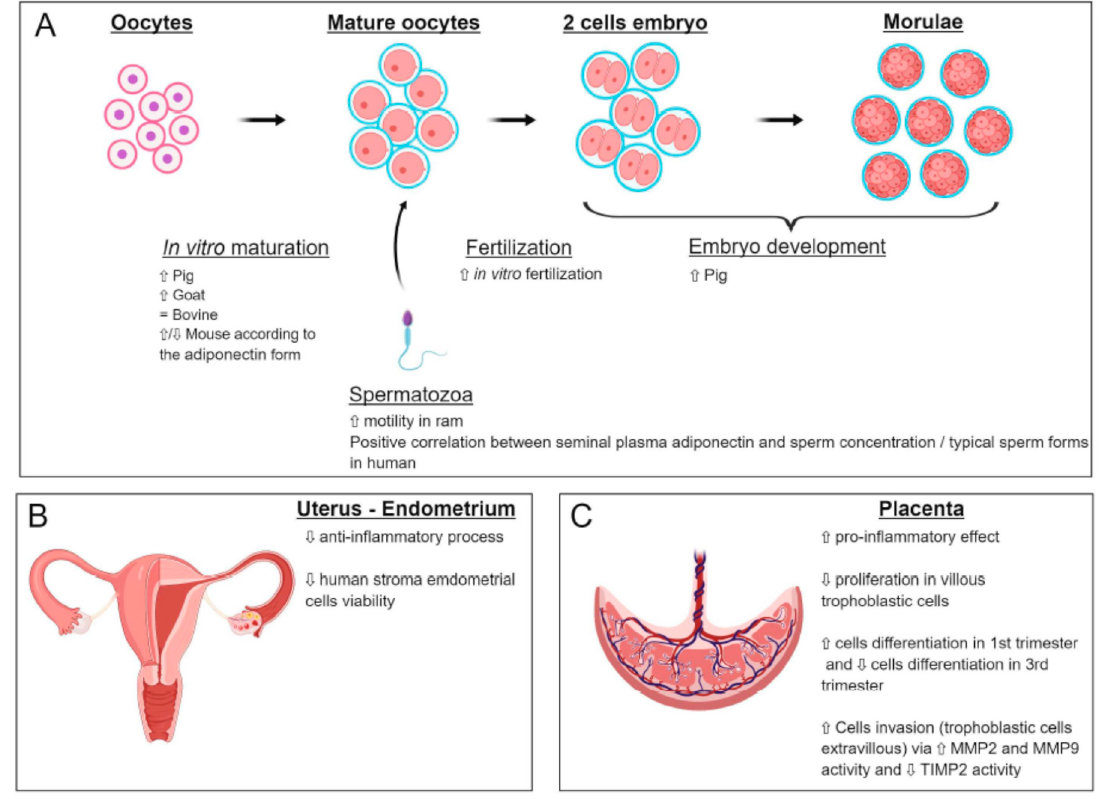
Figure 3. Adiponectin receptors and some examples of biological effects of adiponectin in reproductive tissues or cells. Adiponectin interacts with adiponectin receptors (mainly AdipoR1 and AdipoR2) to activate or inhibit a number of signalling pathways. T Cadherin receptor (T Cadherin R) binds the hexameric and high molecular weight isoforms of adiponectin but it has no intracellular domain. AdipoR1- and R2-dependent signalling is mediated through APPL 1 and APPL2. In the absence of adiponectin signal, APPL2 can bind to the N-terminal domain of the adiponectin receptors or it can form an APPL1/APPL2 heterodimer which prevents the APPL1/adiponectin receptors binding. On the other hand, the binding of adiponectin to its receptors favours the dissociation of this heterodimer. In peripheral tissues, adiponectin receptors have differing affinities for specific forms of adiponectin. In the reproductive tissues the affinities for specific forms of adiponectin is unknown. However, in these tissues, adiponectin regulates different biological effects through various signalling pathways. ⇧ Increase/stimulation. ⇩ Decrease/inhibition.